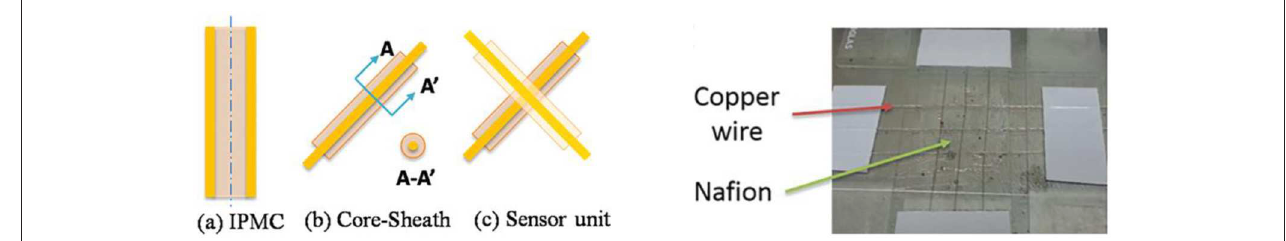
FIGURE 3 | Conceptual design of an ionic polymer pressure sensor derived from the IPMC structure (Zhu et al., 2016a). In (b), the core is a single electrode wire, and the sheath is a Nafion membrane. (a) IPMC, (b) core-sheath, and (c) sensor unit (Left) . Image of the 3 × 3 ionic sensor network (Right) (reprinted with permission).